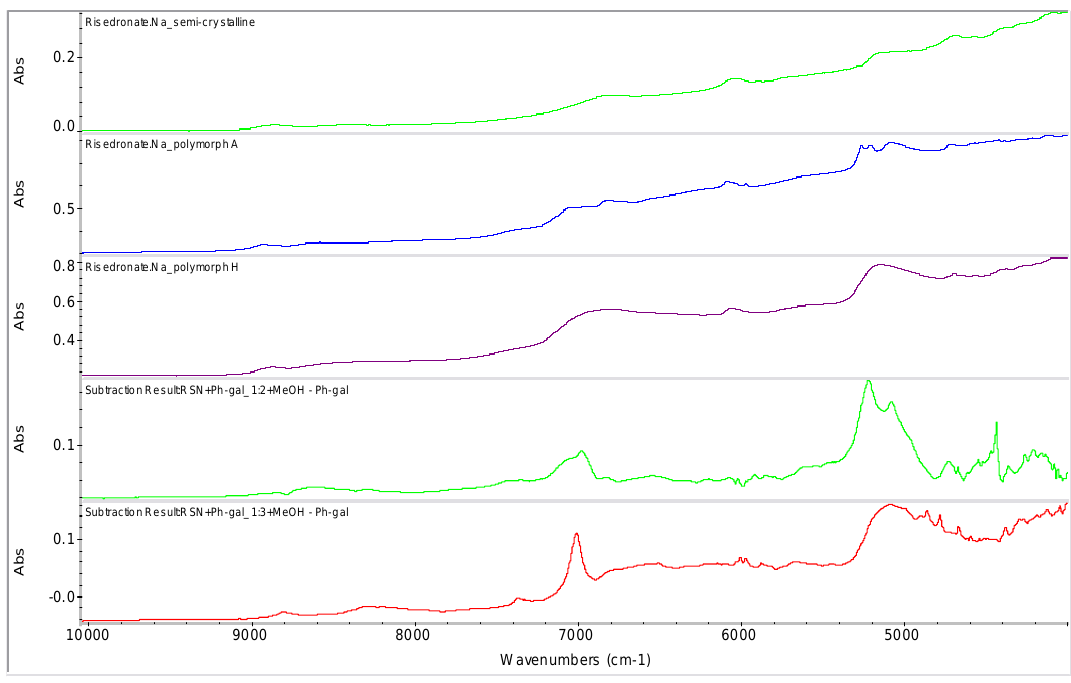
Figure 13. NIR spectra of semi-crystalline risedronate monosodium salt (RSN) and forms A and H and subtracted spectra of samples 6 and 7 (RSN+Ph-gal in ratios 1:2 and 1:3 prepared by addition of MeOH and evaporation of liquid part at ambient temperature).